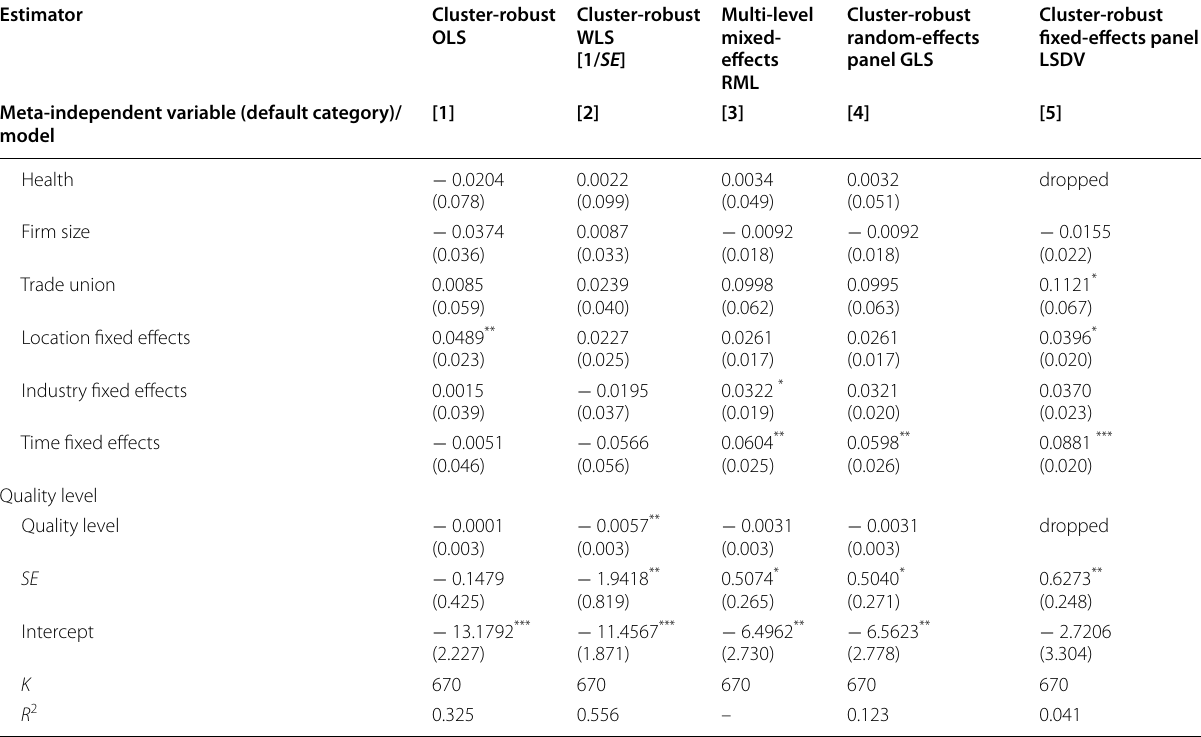
This table shows estimation results of meta-regression analysis using estimates of the gender dummy variable reported in 53 research works listed in Additional file 1: Table S1 and Additional file 2: Bibliography of studies subject to meta-analysis as the dependent variable. See Table 1 for the descriptive statistics of the estimates. See Table 3 for the definitions and descriptive statistics of meta-independent variables. Figures in parentheses beneath the regression coefficients are robust standard errors ***, **, and * denote statistical significance at the 1%, 5%, and 10% levels,